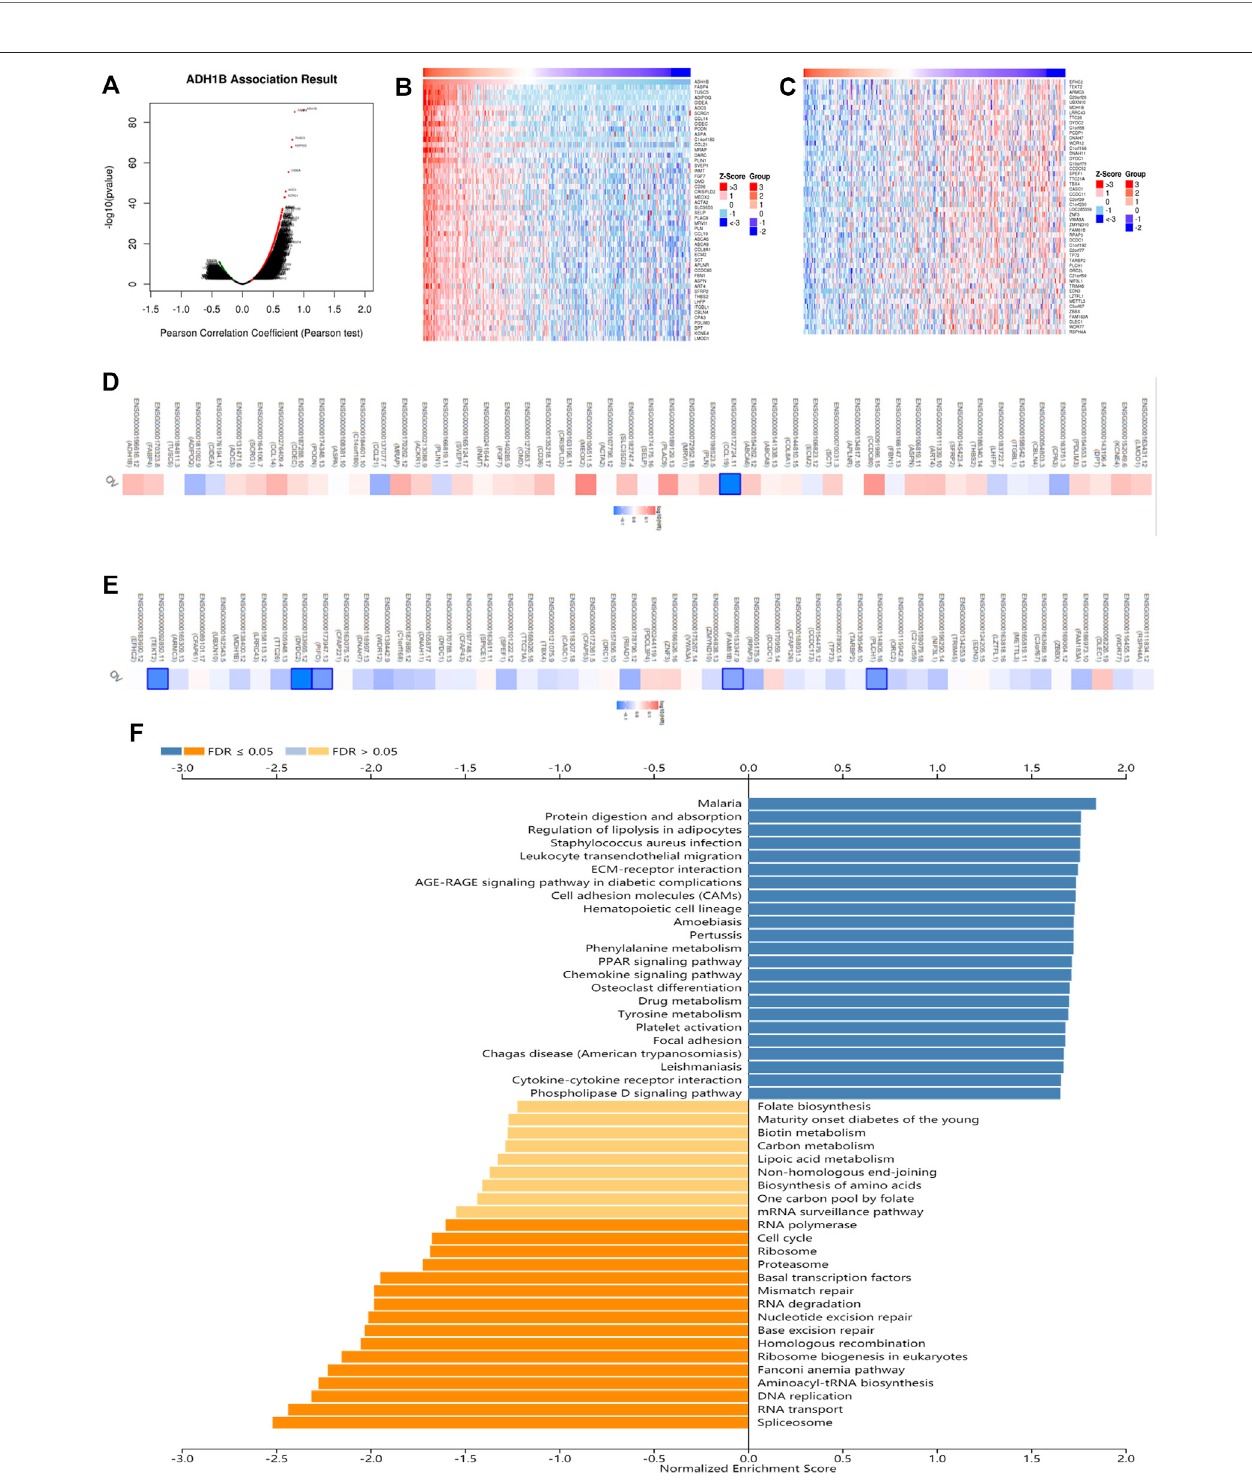
FIGURE 4 | The co-expression analysis of ADH1B in ovarian cancer. (A) The identi fi cation of co-expressed genes remarkably related to ADH1B using the LinkedOmics database. (B,C) The top 50 genes positively and negatively in connection with ADH1B were shown on the heat map. Red indicated positive correlations while blue negative. (D,E) The top 50 genes having positive and negative associations with ADH1B were presented on the survival heat map. (F) Bar chart of the KEGG enrichment analysis of ADH1B.